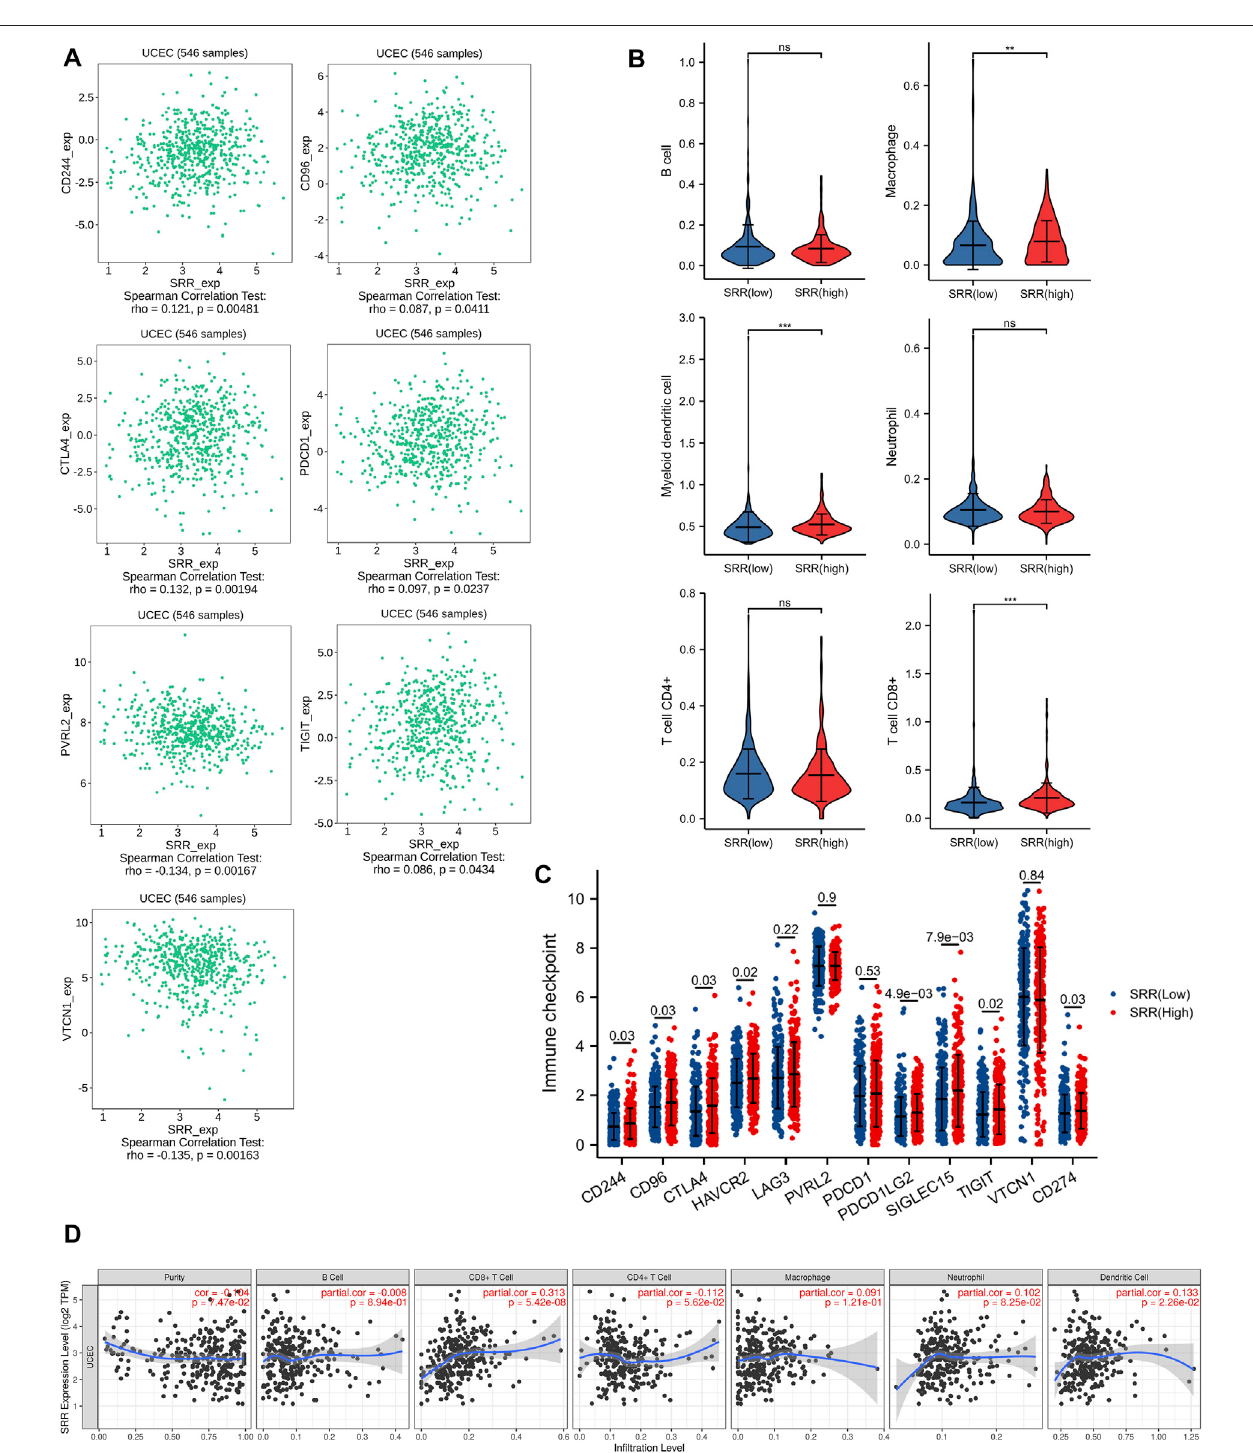
FIGURE 3 | Immune-related analysis of SRR in UCEC. (A) Seven immune inhibitors signi fi cantly correlated with SRR expression using TISIDB. (B) Violin plots showing the different immune in fi ltration levels in SRR high and low groups. (C) The comparison of the expression of immune checkpoint-related genes between UCEC SRR-high expression group (red) and SRR-low expression group (blue); the number indicates the p -value. (D) Correlation between SRR expression and immune cell in fi ltration levels in UCEC.